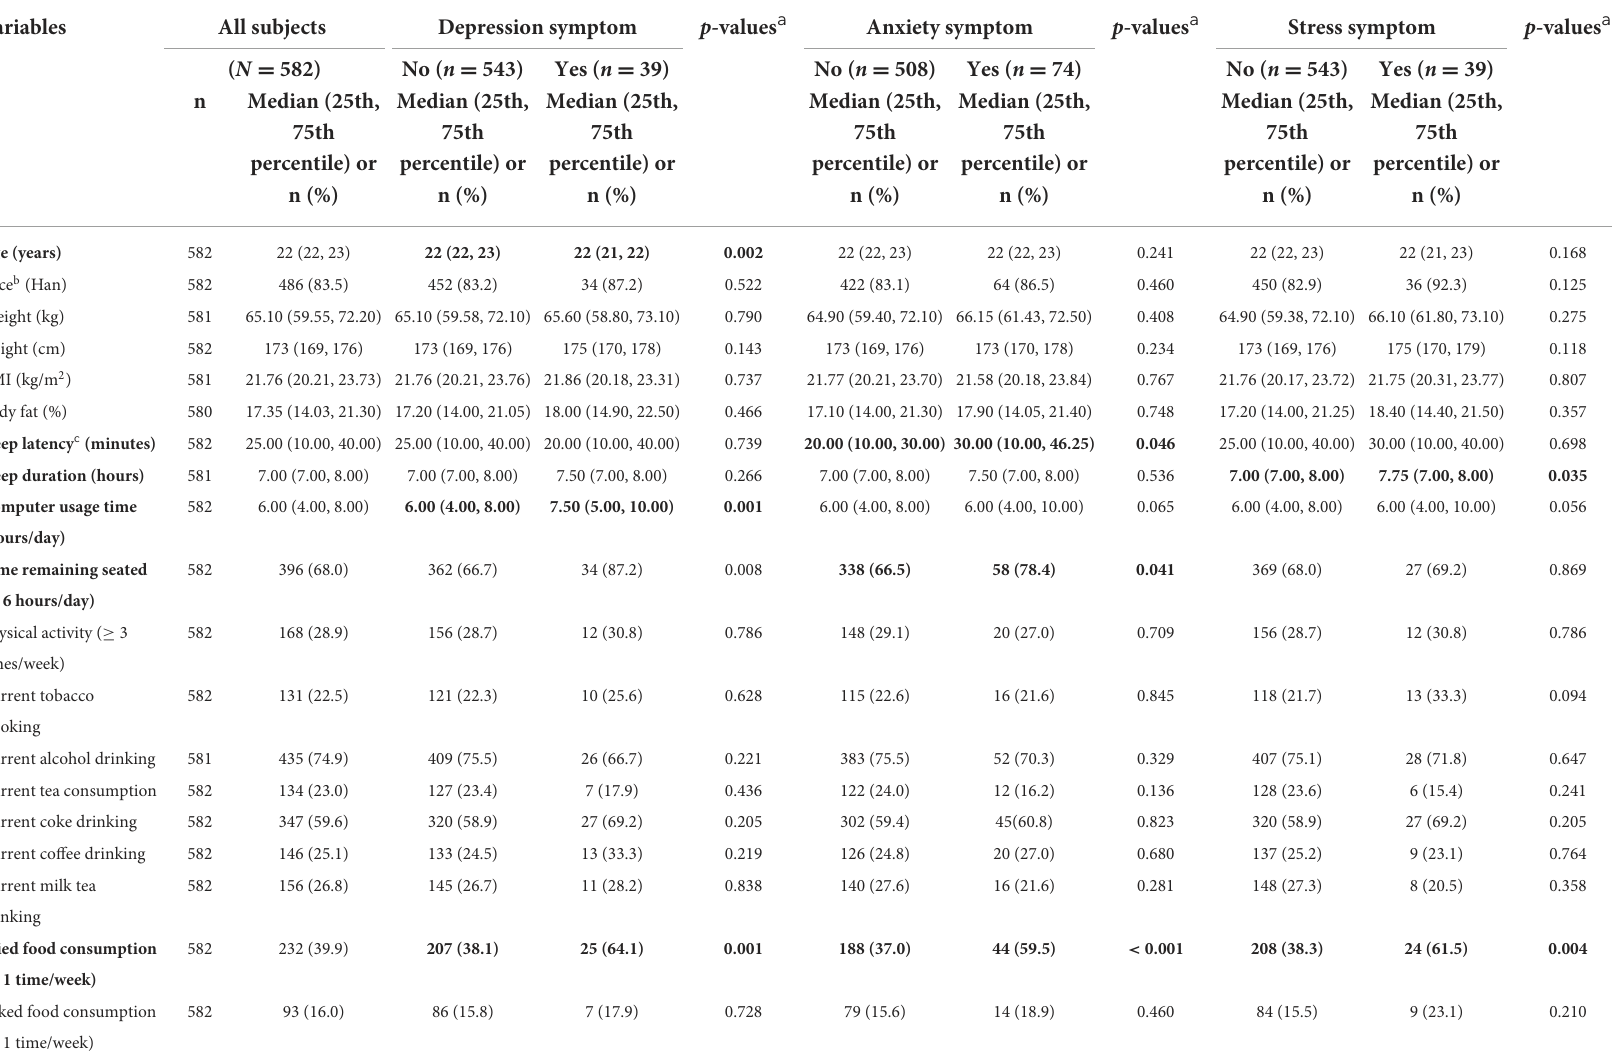
TABLE 2 The distribution of demographic characteristics and lifestyle factors according to the status of depression, anxiety, and stress symptoms among 582 male college students at follow-up (year